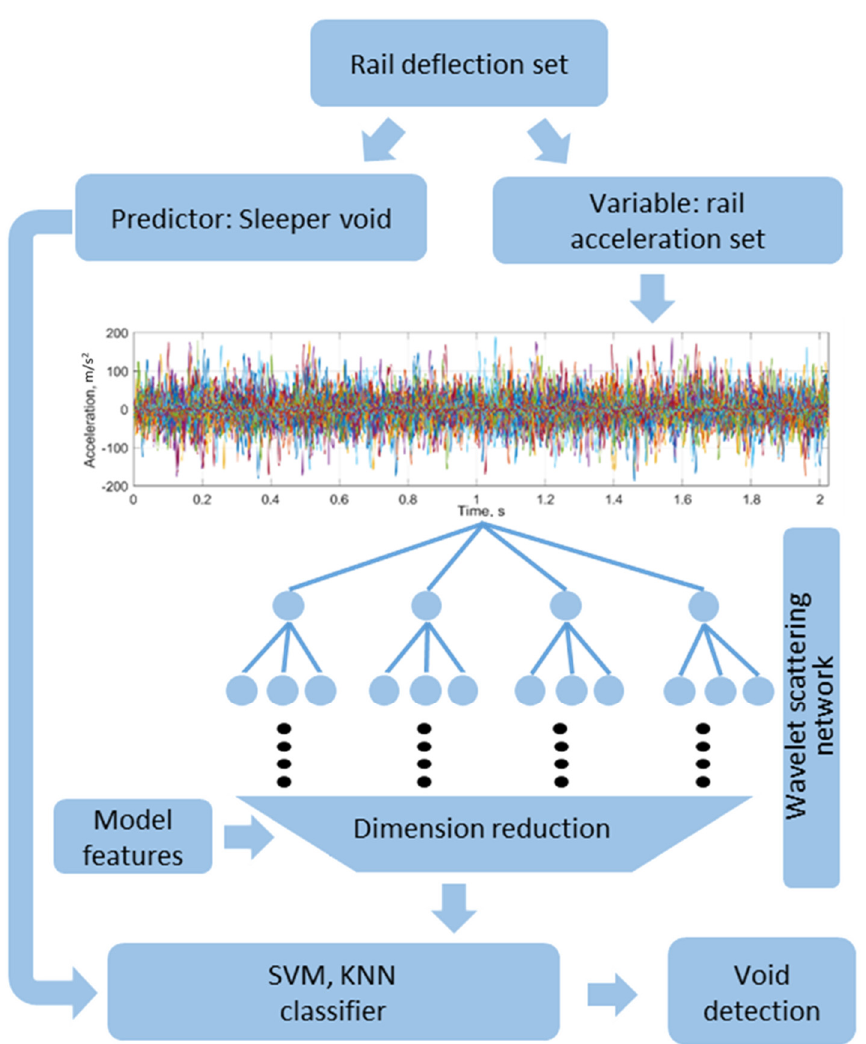
Figure 15. Flowchart of statistical processing for void identification.